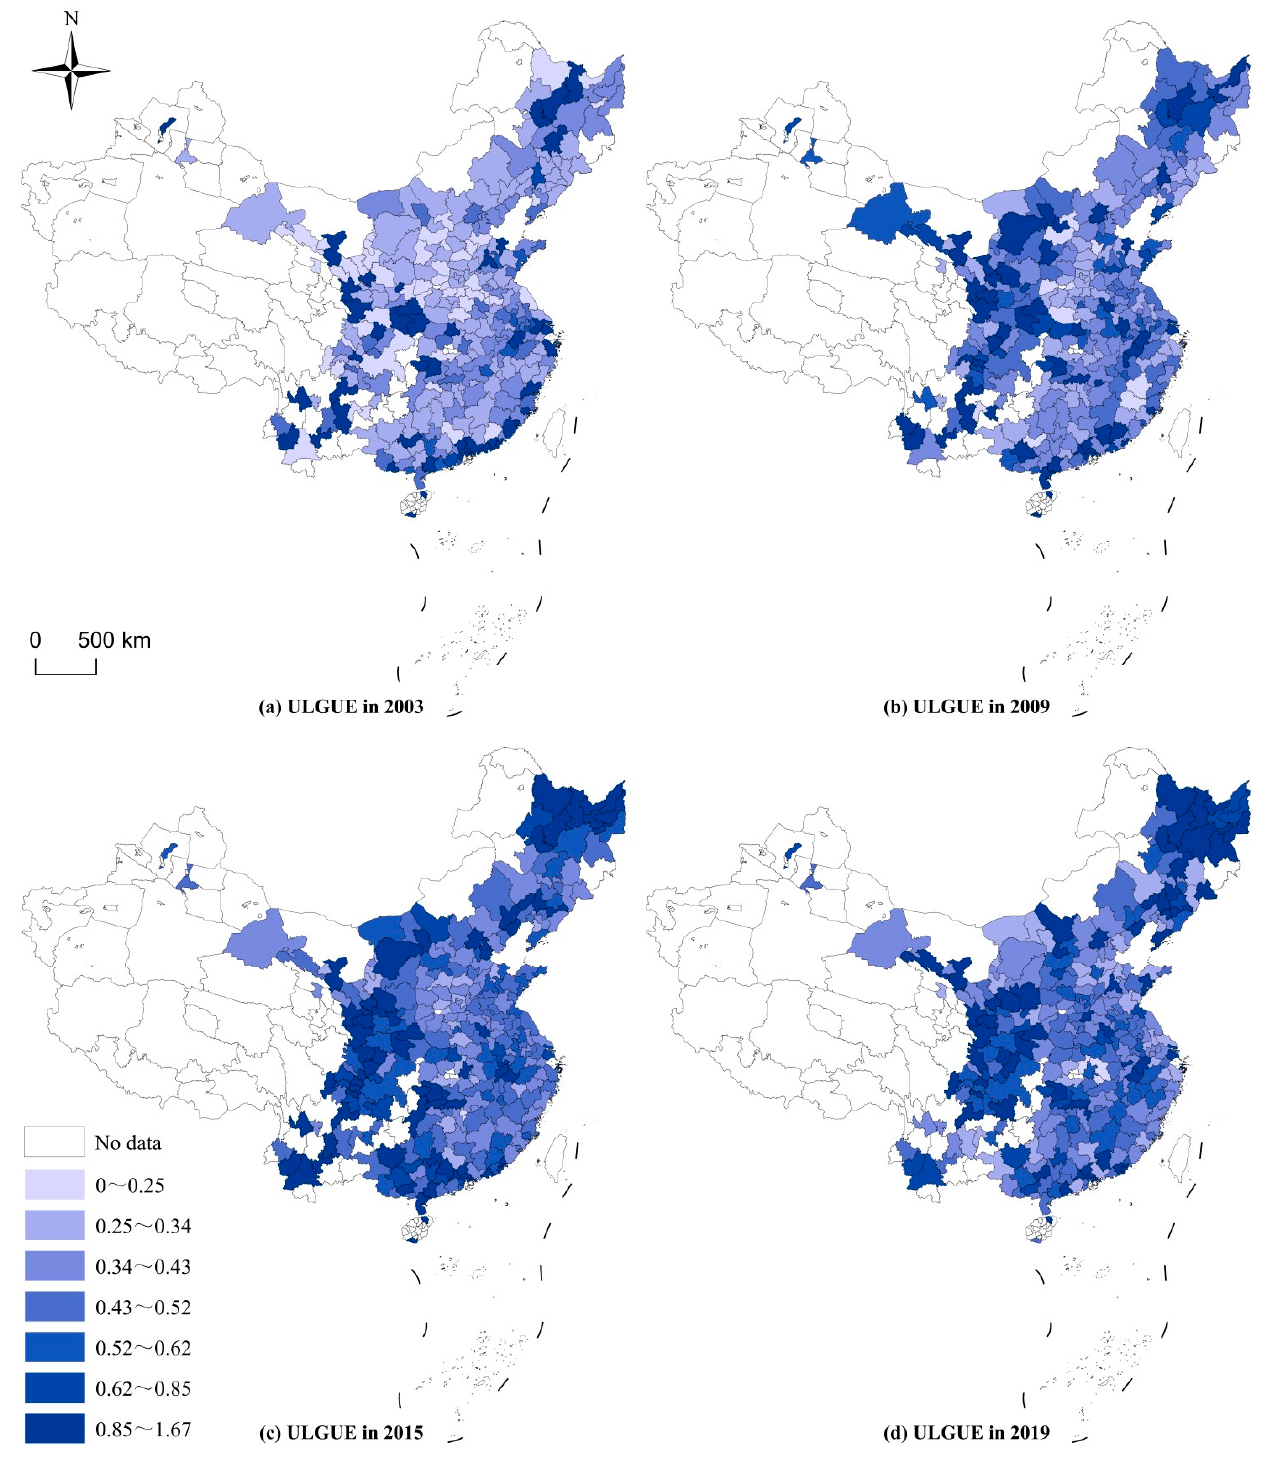
Figure 3. Result for urban land green use efficiency in 283 cities in China from 2003 to 2019. ( a ) Result for urban land green use efficiency in 2003. ( b ) Result for urban land green use efficiency in 2009. ( c ) Result for urban land green use efficiency in 2015. ( d ) Result for urban land green use efficiency in 2019.